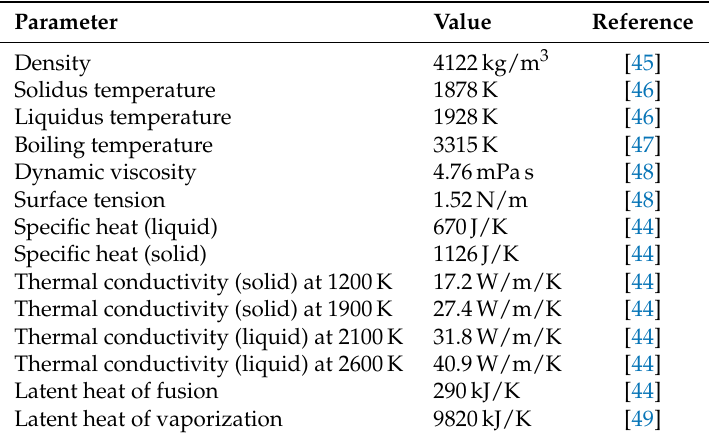
Table 1. Material properties of Ti-6Al-4V used in